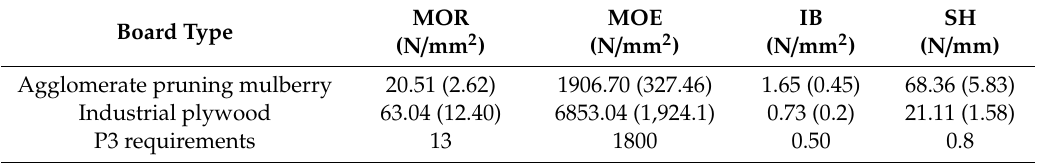
Table 3. Properties of the mulberry and industrial plywood boards.